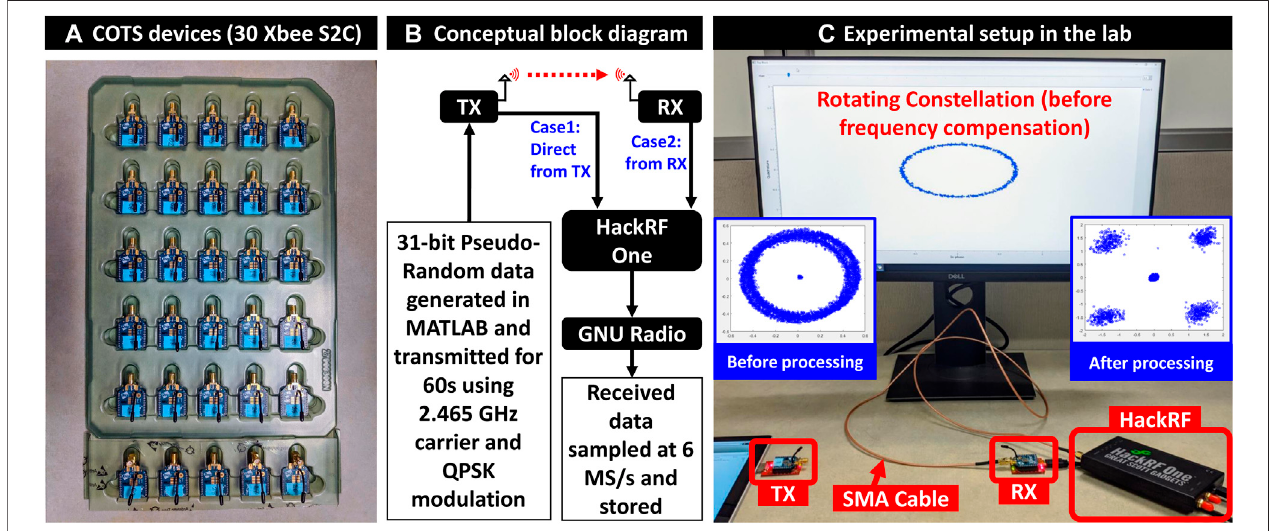
FIGURE 2 | (A) Commodity off-the-shelf devices (30 Xbee S2C modules) used as transmitters for data collection. (B) Conceptual experimental setup. (C) Actual experimentalsetupinthelab.TheTXandRXareplaced1 mapart(theyareclosehereforimagecapturingpurposesonly)andaHackRFmodulewasusedtocollectdata either from the TX (case 1) or RX (case 2). GNU Radio records the collected data and shows a live constellation (visible on-screen). The rotating constellation is later processed in MATLAB through coarse and fi ne frequency compensation.